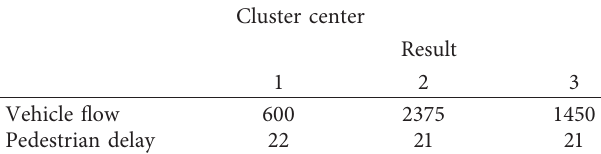
Figure 10: Scatter plot of pedestrian delay with two forms of flow. Table 5: Clustering center of vehicle flow and pedestrian